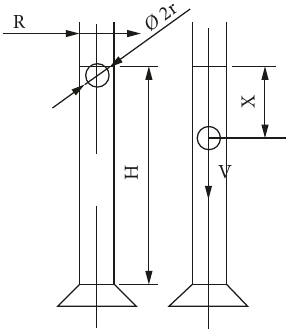
Figure 1: Schematic diagram of the